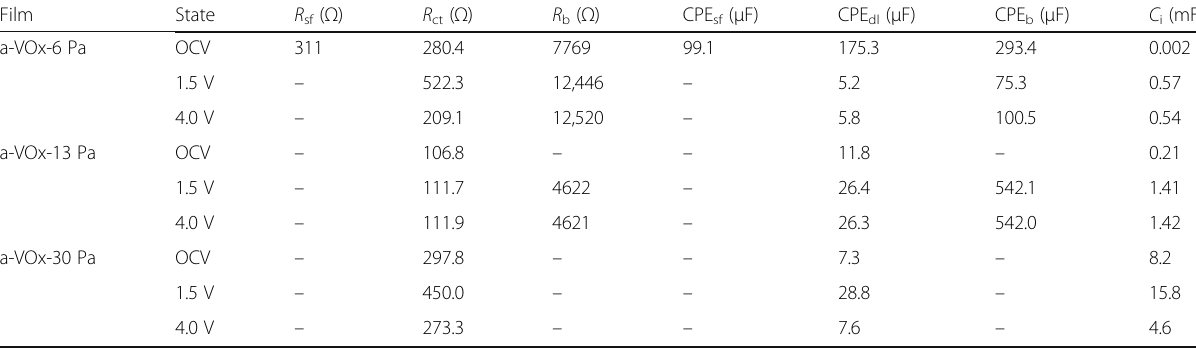
Table 7 Na-ion battery impedance analysis of a-VOx films